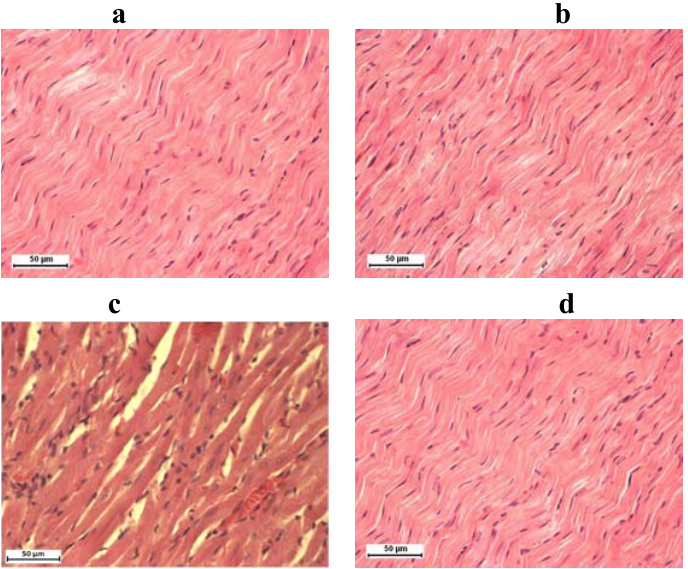
Figure 2. Rat heart stained with H&E technique, 400× magnification: ( a ) control groups, ( b ) group treated with silymarin, ( c ) doxorubicin, ( d ) and combination of doxorubicin and